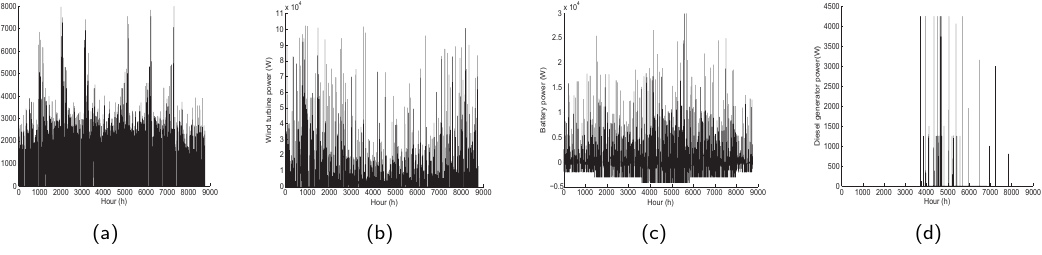
Figure 7. Power generation in mode I. ( a ) PV; ( b ) wind generator; ( c ) battery; ( d ) diesel generator.